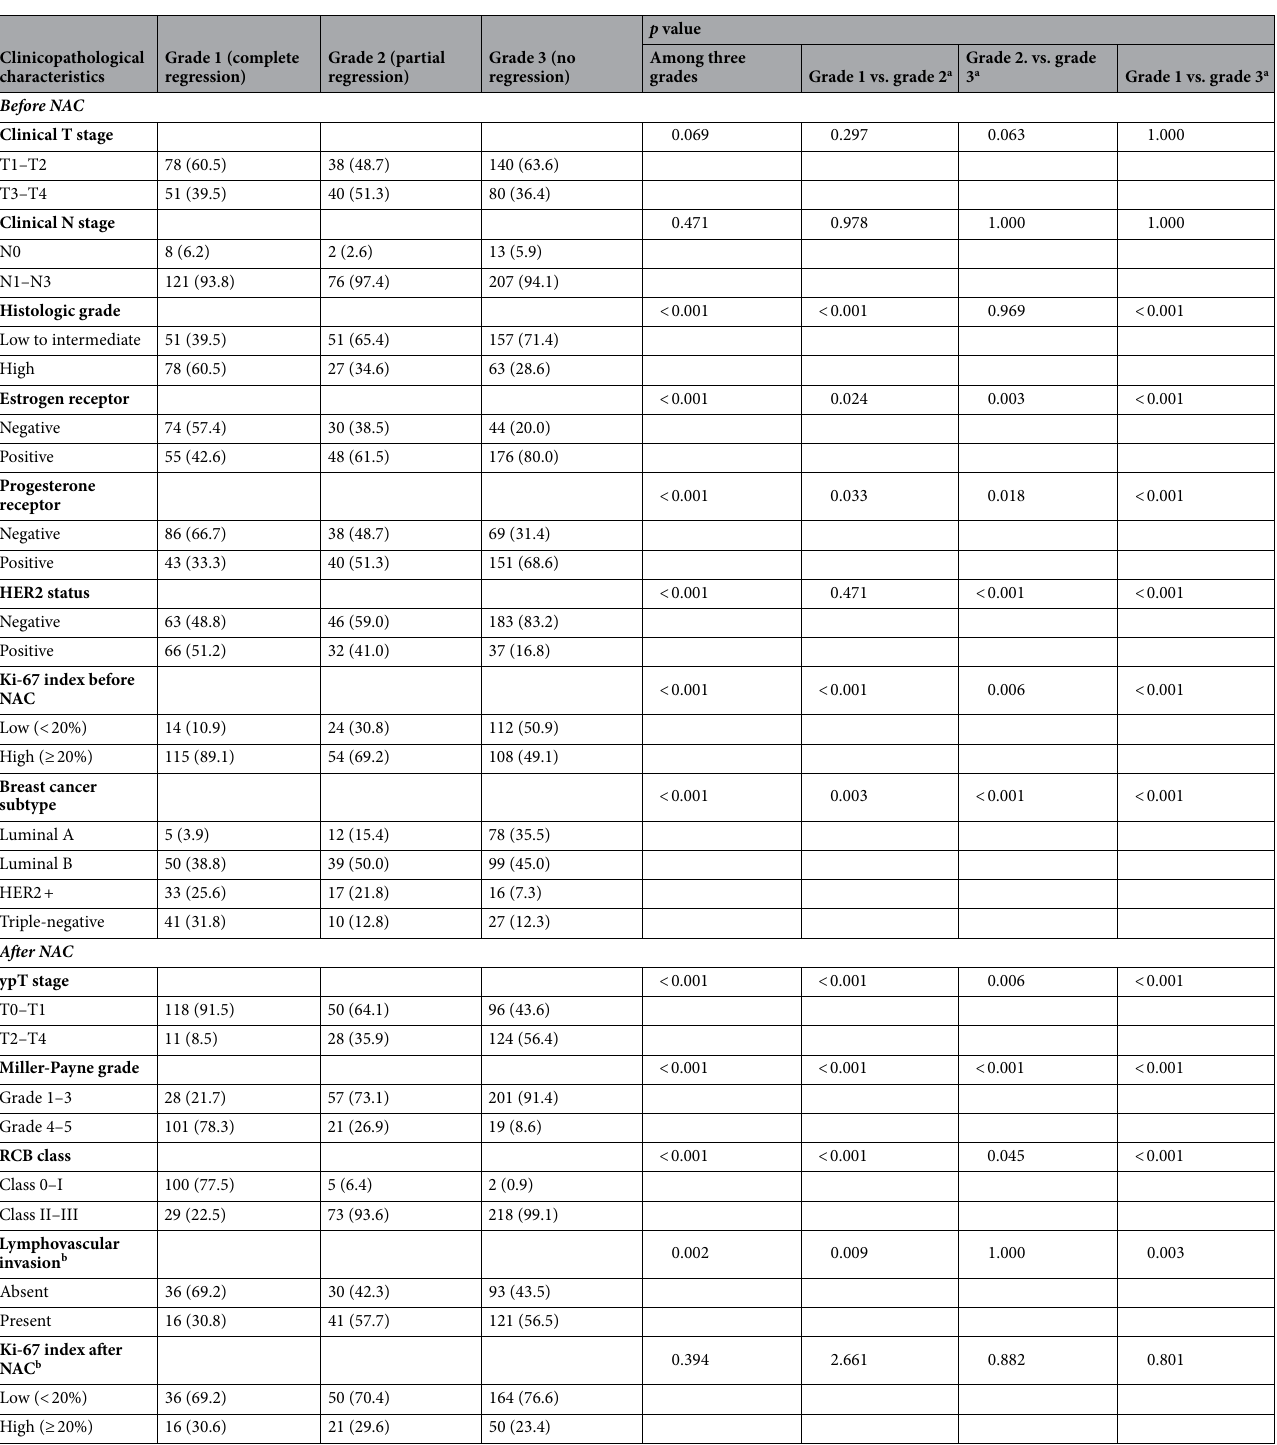
Table 3. Clinicopathological characteristics of tumors according to chemo-responsiveness of lymph nodes. NAC neoadjuvant chemotherapy, RCB residual cancer burden. P values were calculated by the chi-square test or Fisher’s exact test. Numbers in parentheses indicate percentage. a Corrections for multiple testing were made by Bonferroni method, and adjusted (adj.) p values were presented. b These characteristics were evaluated in cases with residual disease in